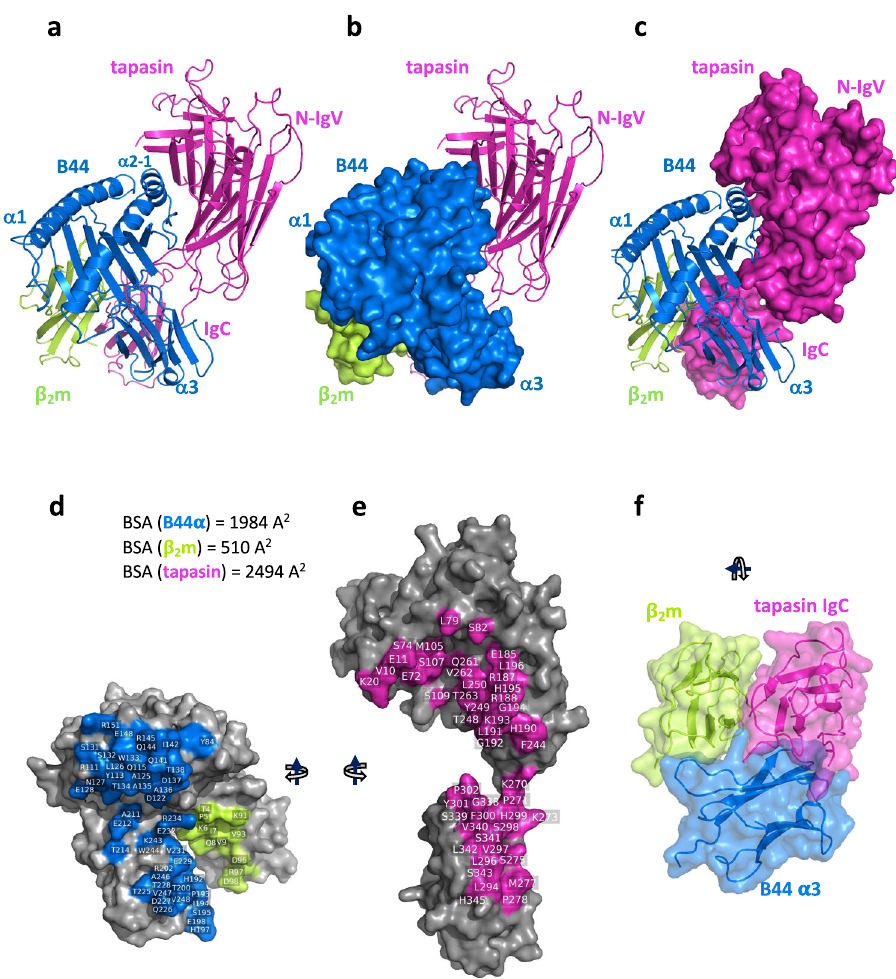
Fig. 2 | Overall structure of the Tapasin – B44:05 – 6mer complex. a Ribbon representation of Tapasin (magenta), B44:05 heavy ( α ) chain (blue), and β 2 m light chain(lime). b Similarto a ,butwithB44:05 α and β 2 minsurfacedisplay. c tapasinin surface display. d Interface residues of B44:05 α and β 2 m in surface display, with